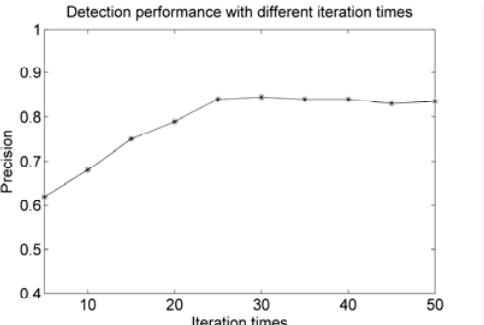
Figure 6. Effects of location and property classifiers for learning